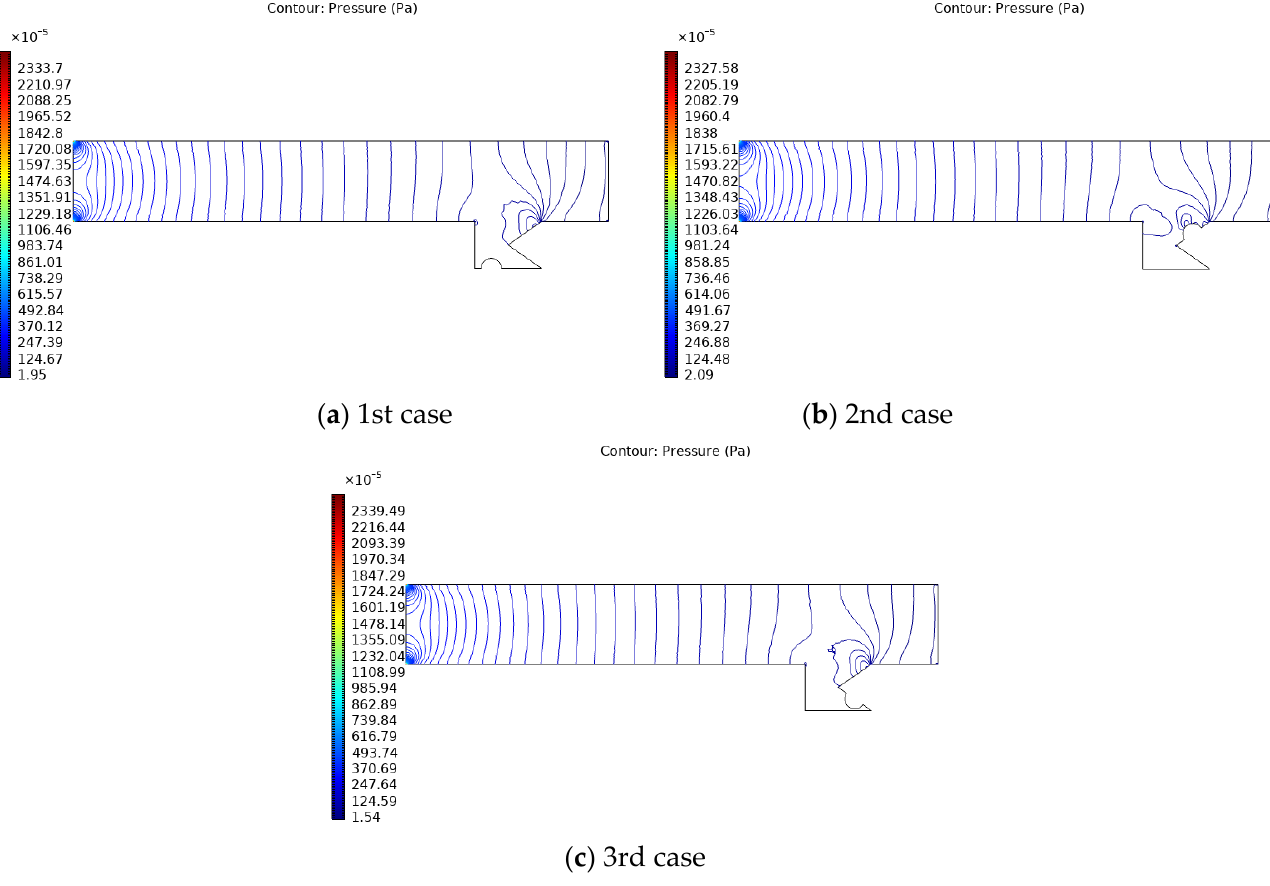
Figure 6. Pressure streamline contour through the assembly .